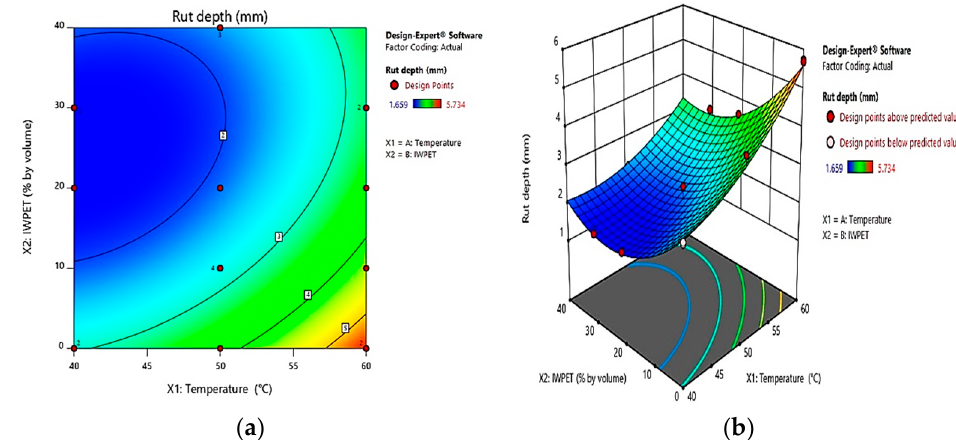
Figure 12. Influence of temperature and IWPET on rutting ( a ) 2-dimensional, ( b ) 3-dimensional.